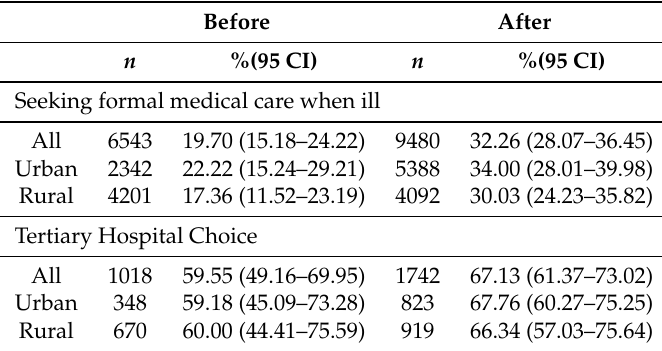
Table 3. Trends in health service utilisation and choice of tertiary hospitals,